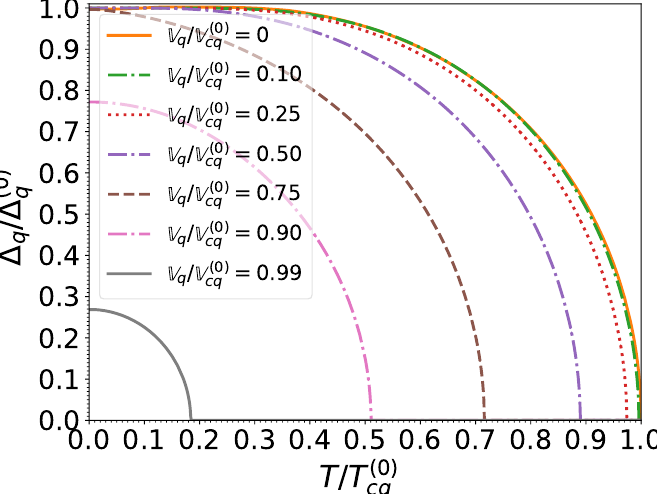
Figure 4. 1 S 0 nucleon pairing gap relative to that at zero temperature and in the absence of superflow, as a function of the normalized temperature T / T ( 0 ) velocities V q / V cq